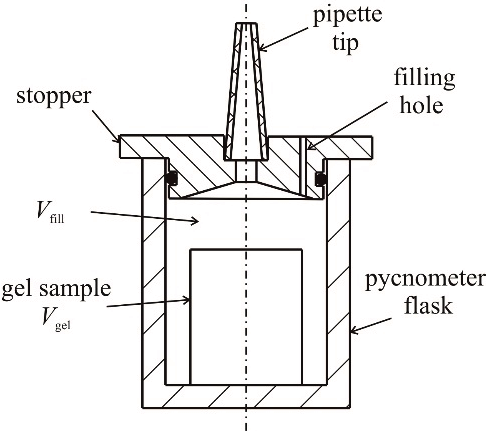
Figure 4. Cross-section of the adapted pycnometer